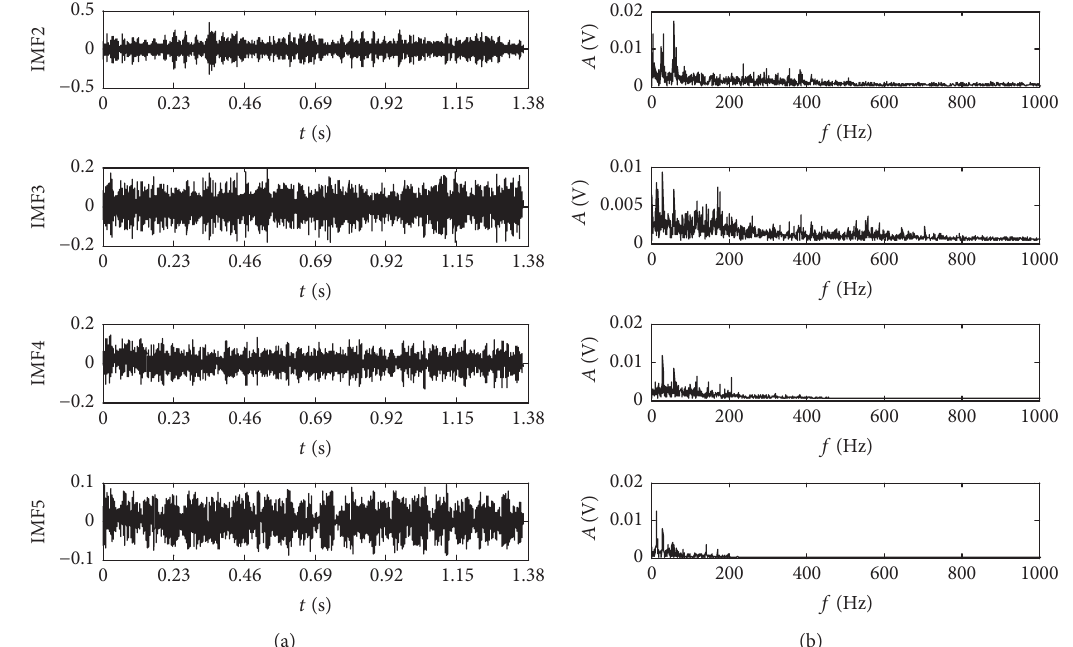
Figure 8: Analyzed results of EEMD: (a) IMFs; (b) the envelop spectrum of IMFs.